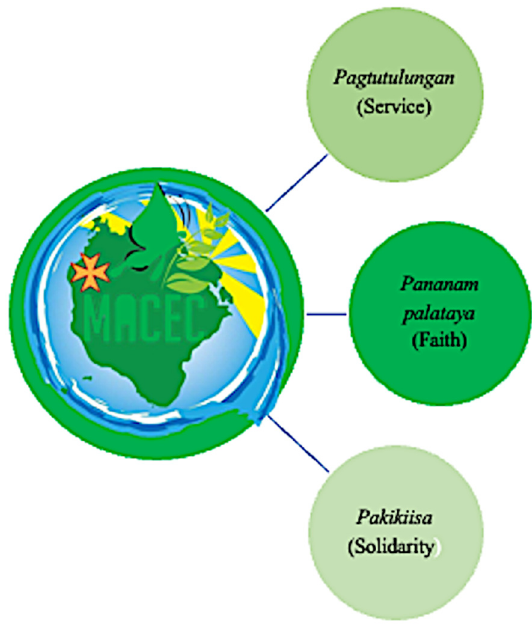
Figure 3. The conceptual framework of ecological care.